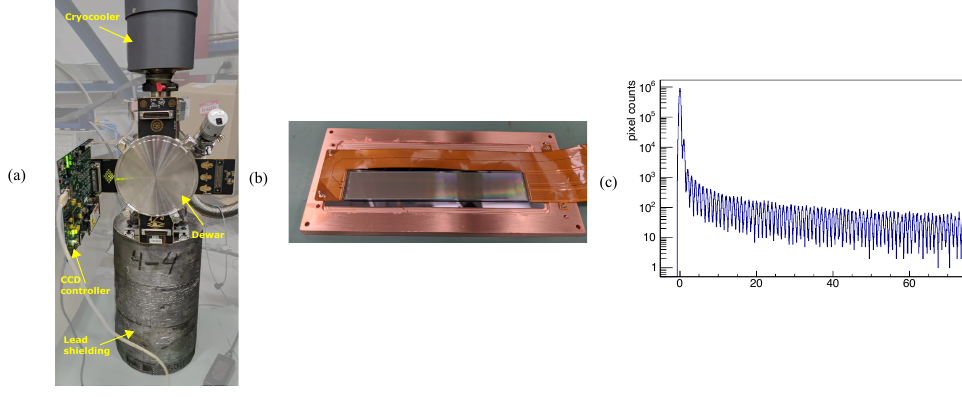
Figure 17: (a) Setup used for the Skipper-CCD experiment with a short description of the main components. (b) A picture of the CCD installed on the copper tray. An extra copper plate that covers the top part of the sensor is not presented in the image. (c) Histogram of pixels with charge up to 100e − after calibration. Single